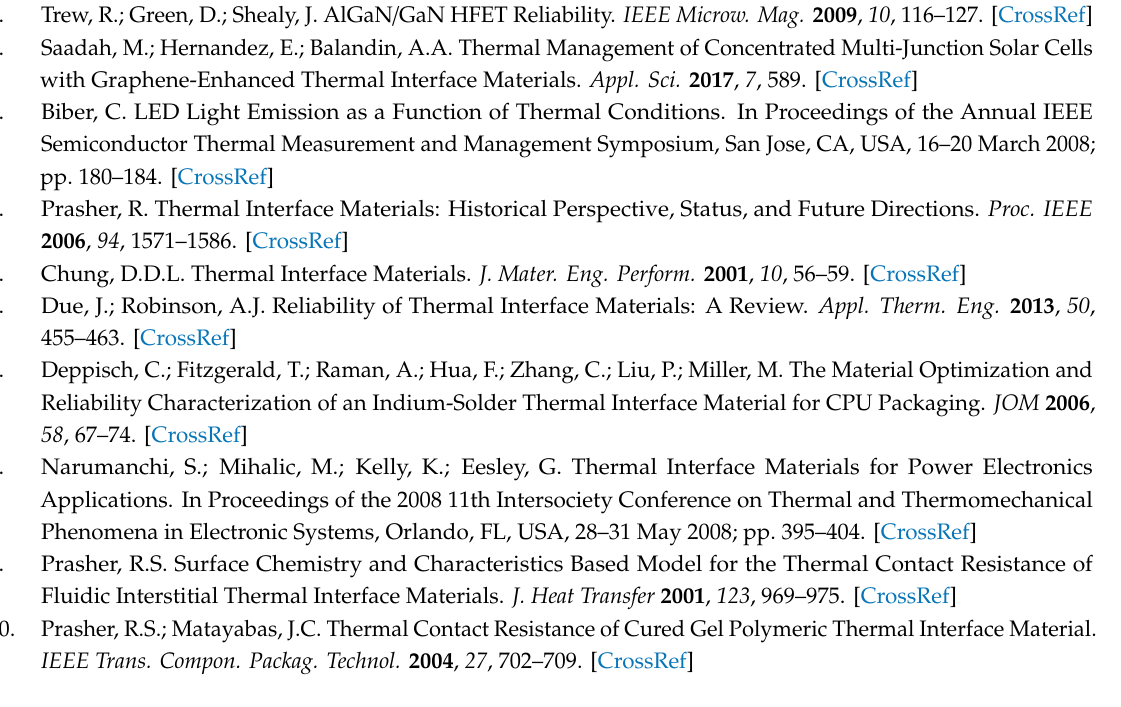
Figure S1: A three-dimensional visualization of the thermal di ff usivity enhancement in the 30 vol% composite, Figure S2: A SEM micrograph of a fractured surface of a 5.4 vol% composite, Figure S3: Raman spectrum of a 5.4 vol% composite, Figure S4: Di ff erential scanning calorimetry experimental results of our pure epoxy matrix, and Figure S5: Plot of temperature over time for the power cycling